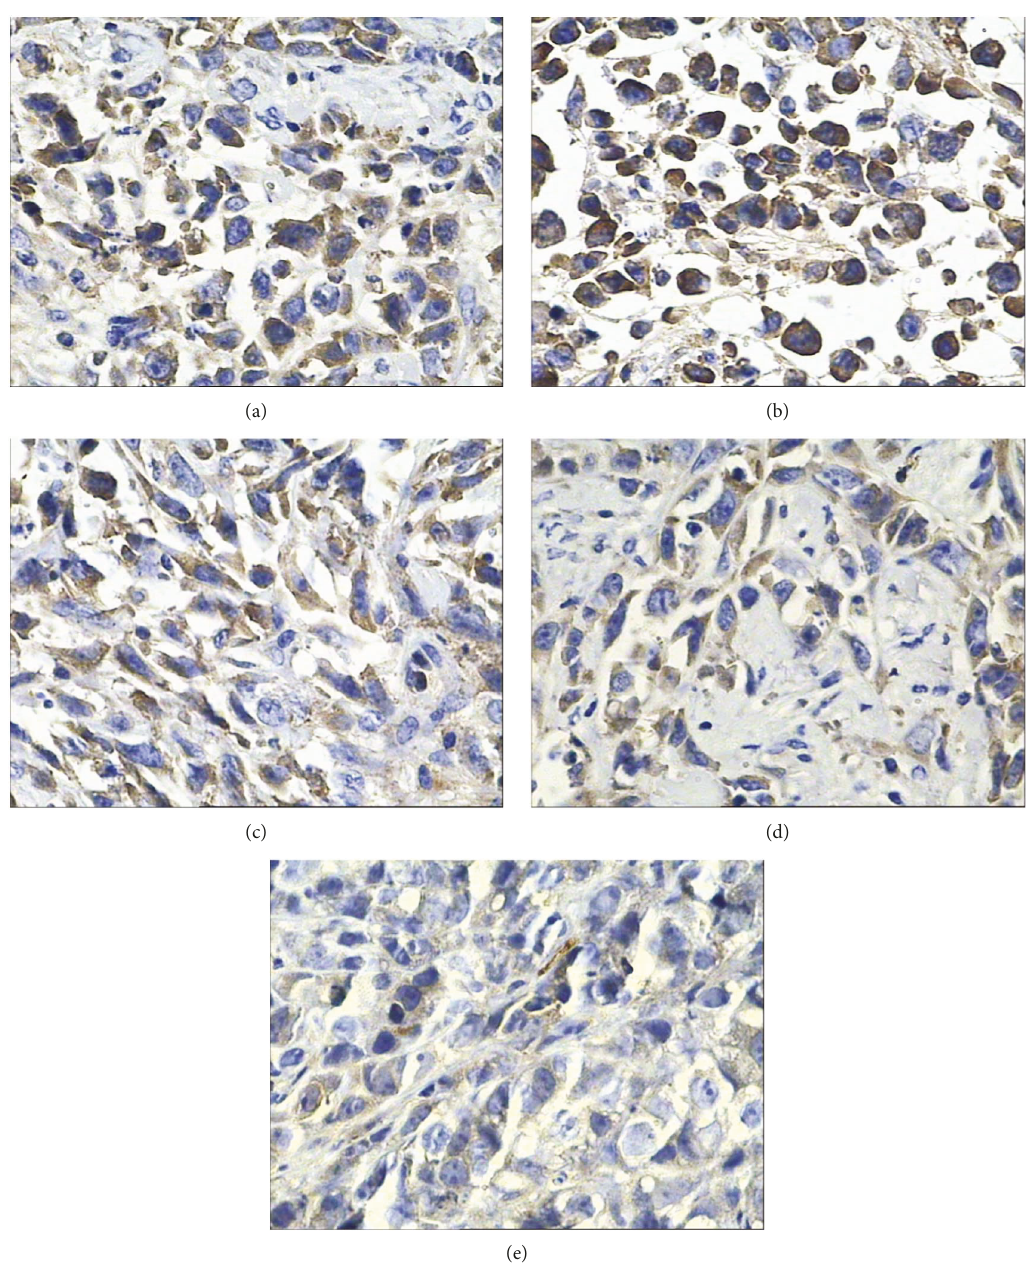
Figure 7: VEGF protein expression in hepatoma tissues after di ff erent treatments tested by IHC (400x). (a) Saline control group. (b) Radionuclide group. (c) Radionuclide-gene group. (d) MFH group. (e) Radionuclide-gene-MFH